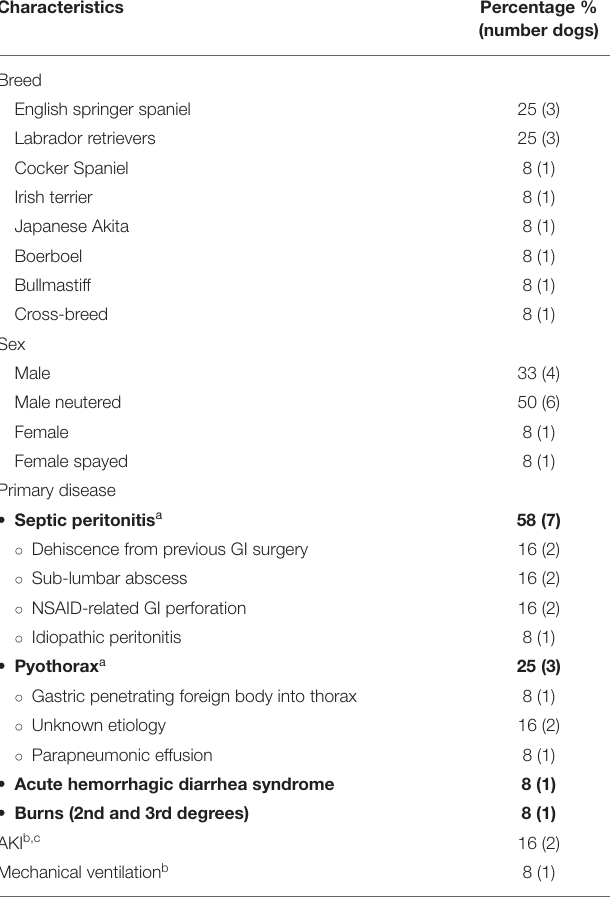
TABLE 2 | Demographic, clinical, and treatment characteristics of sick dog population. Characteristics